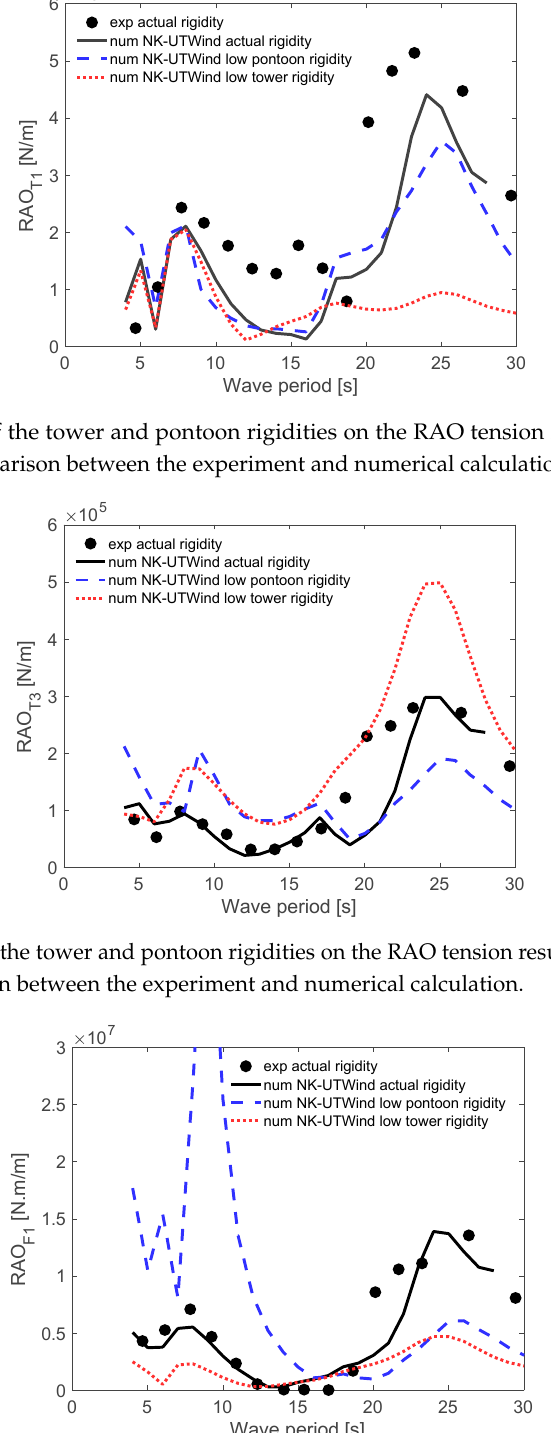
Figure 21. Influence of the tower and pontoon rigidities on the RAO bending moment at the side- pontoon gage (A3), and its comparison between the experiment and calculation.